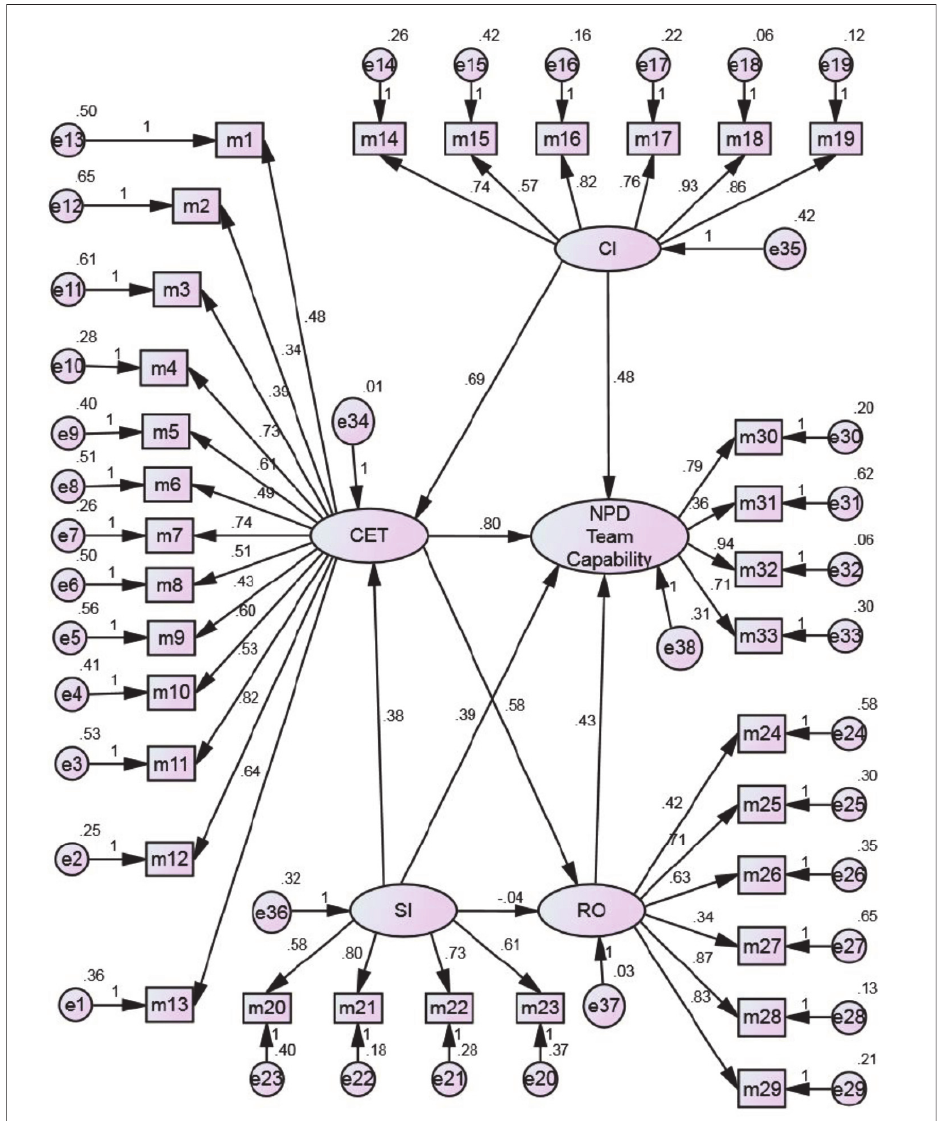
Fig. 2. Structural Equation Modeling (SEM) model after execution portraying the combined impact of teamwork and its associated factors on NPD team’s